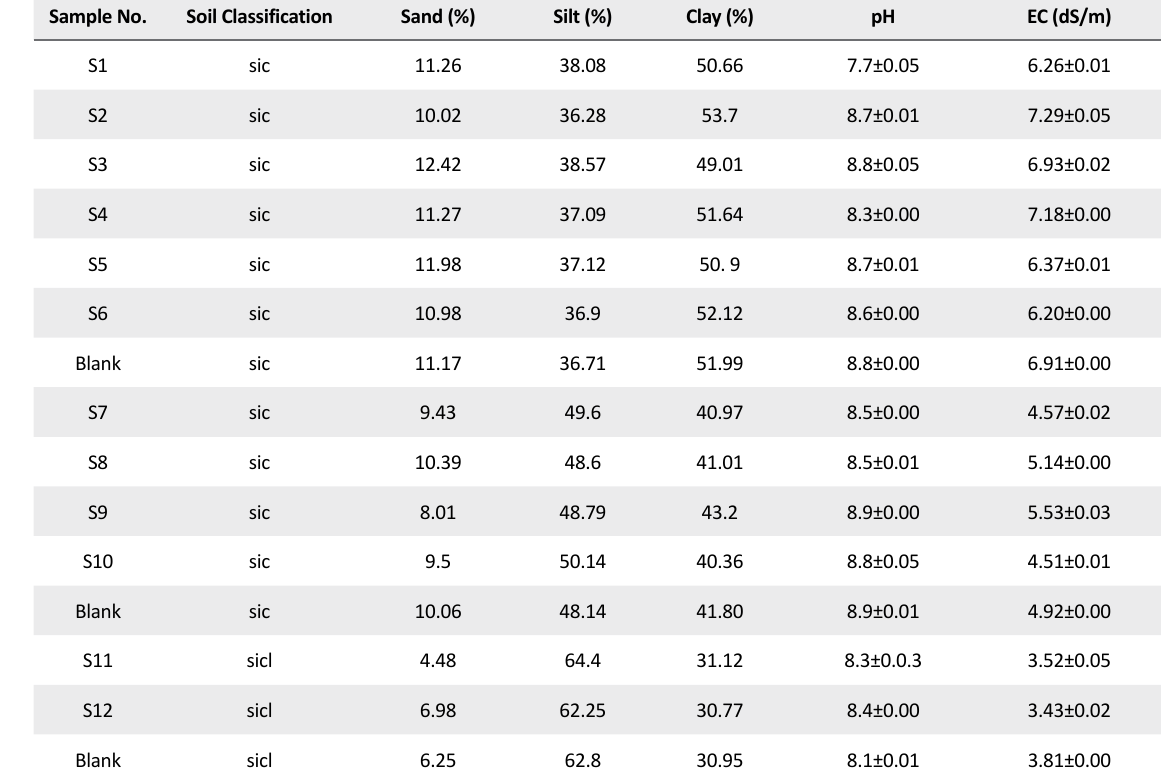
Table 2. Selected physicochemical properties of the soils in each sampling site Sample